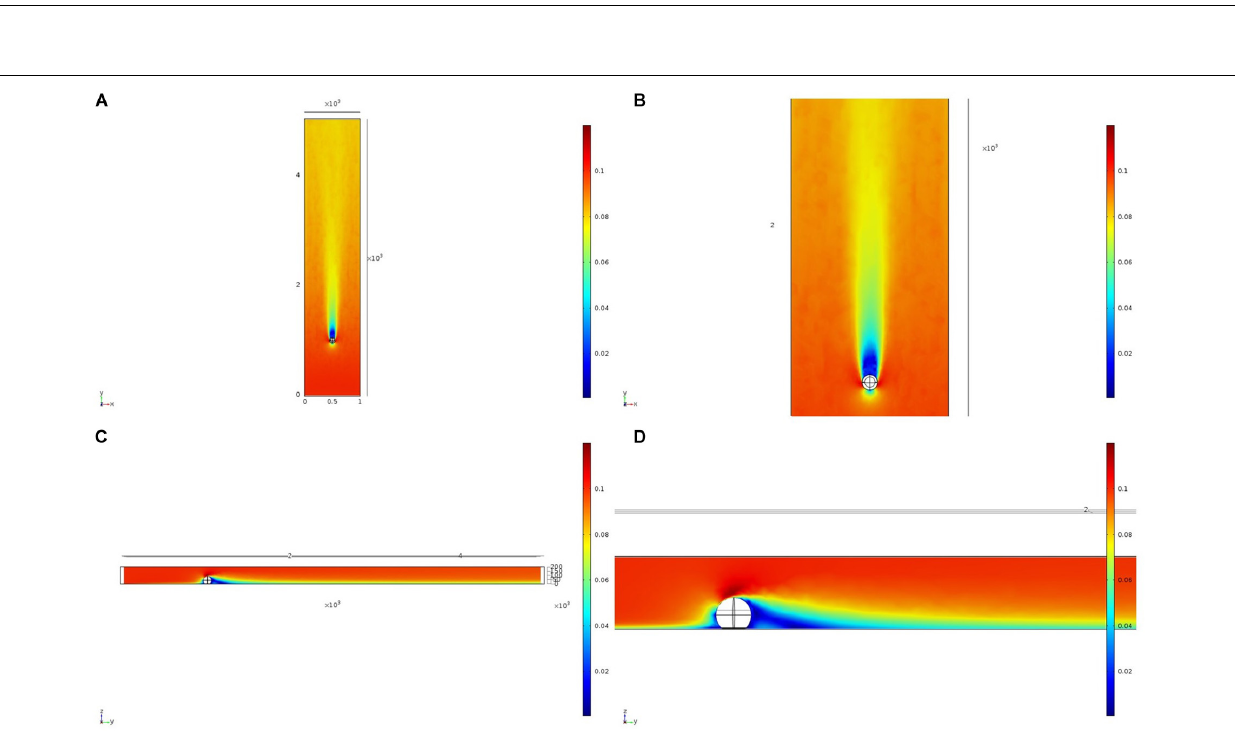
FIGURE 4 | Results of the fluid flow finite element analysis simulation for an idealized sphere, visualized as two-dimensional plots [horizontal (A,B) and vertical (C,D) cross sections] of flow velocity magnitude (false-color scales m/s). Scale in mm with ambient flow of 0.1 m/s along the y -axis. (B,D) Zoom in on the wake close to the